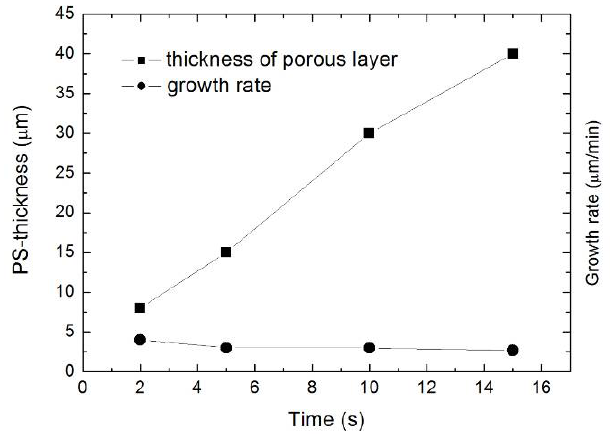
Figure 5. Diagram corresponding to Table 1, showing the parameters thickness of the porous layer and the growth rate in dependence on the time.